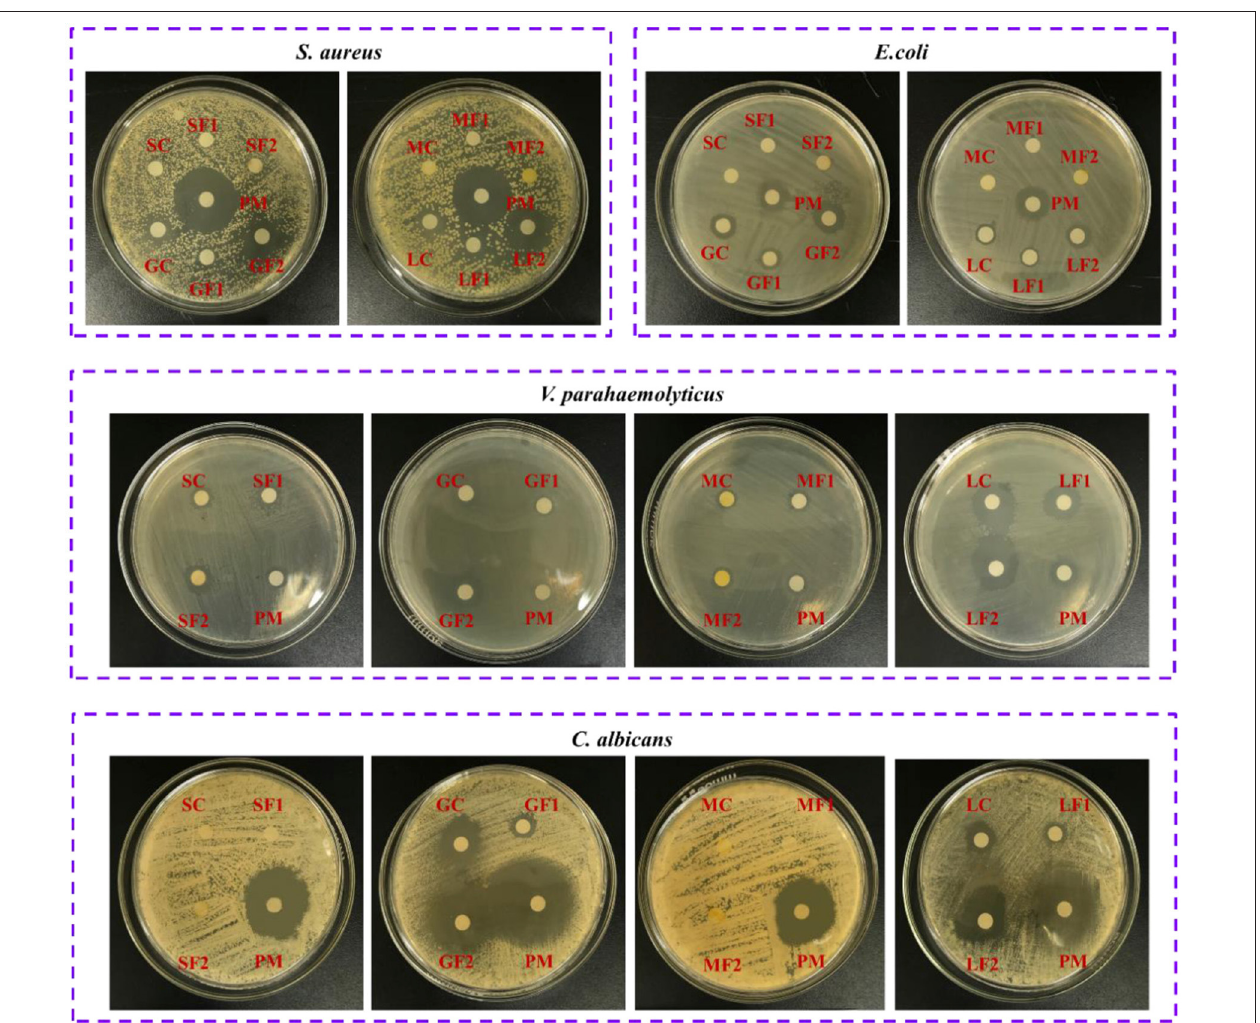
FIGURE 6 | The inhibition effects of citrus EOs against S. aureus , E. coli , V. parrahaemolyticus , and C. albicans (SOC, sweet orange crude oil; SOF1, fraction 1 of sweet orange oil; SOF2, fraction 2 of sweet orange oil; GFC, grapefruit crude oil; GFF1, fraction 1 of grapefruit oil; GFF2, fraction 2 of grapefruit oil; MAC, mandarin crude oil; MAF1, fraction 1 of mandarin oil; MAF2, fraction 2 of mandarin oil; LEC, lemon crude oil; LEF1, fraction 1 of lemon oil; LEF2, fraction 2 of lemon oil; PM, positive